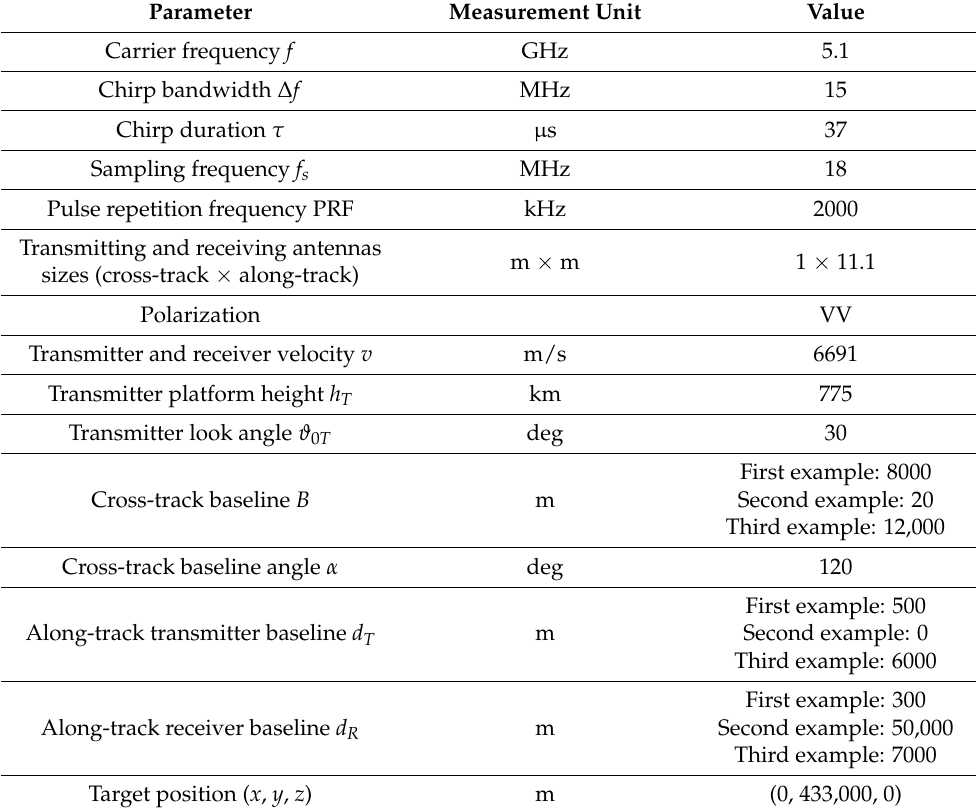
Table 1. System parameters of the TI bistatic SAR configuration considered in the